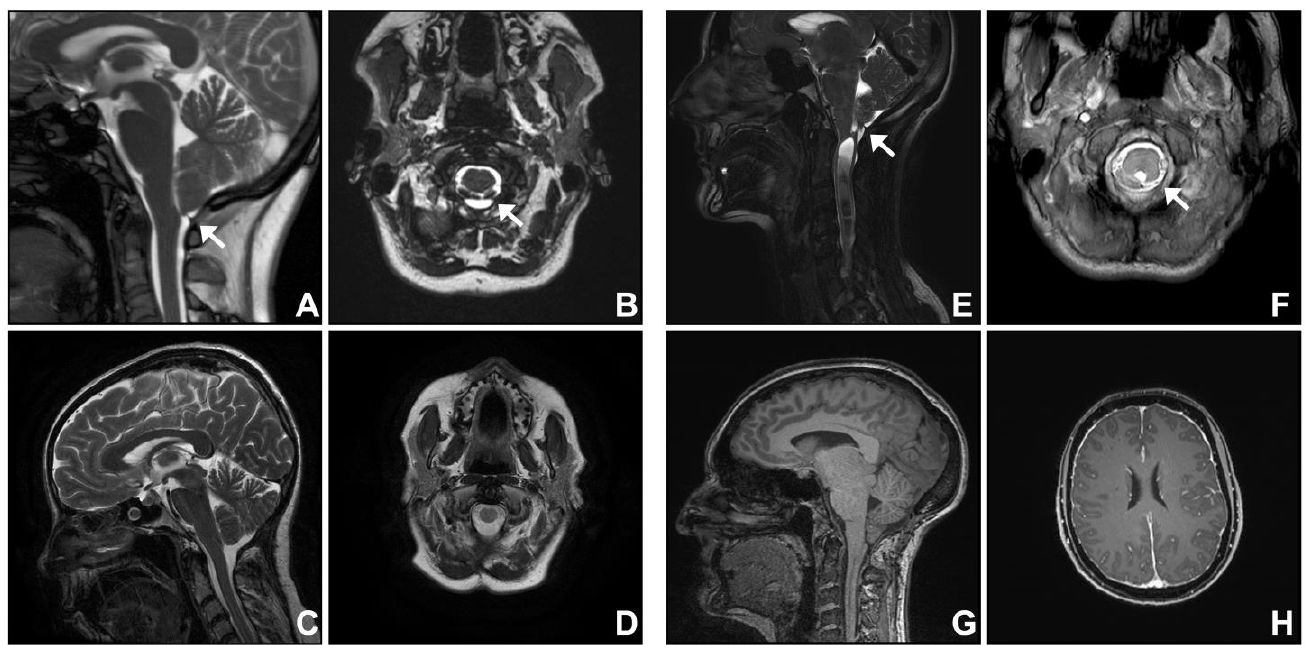
Figure 2. Chiari mimic: dural band. A 41-year-old woman ( A – D ) presented with a 4-year history of occipital headache and neck and bilateral upper limb pain. Cardiac gated steady-state free precession (SSFP or bFFE) imaging as well as thin-slice, heavily T2-weighted images showed cerebellar tonsillar descent, a thick dural band compressing the cerebellar tonsils (( A , B ); white arrows), and a resultant reduction of cisterna magna ( A , B ). Decompression surgery and division of the dural band restored the cisterna magna to a normal size ( C , D ). A 49-year-old woman ( E–H ) presented with a 9-year history of hearing changes and sensory disturbance in the left upper limb and trunk. An MRI showed cerebellar tonsillar descent 7 mm below the foramen magnum up to the C1 arch with a communicating cervico-thoracic syrinx ( E ). In addition, compression of the tonsils at the cervico-medullary junction was evident from a distinct septation posteroinferior to the cerebellar tonsils (( E,F ); white arrows) on cardiac-gated cine bFFE sequence ( E,F ). Following posterior fossa decompression, there was persistent cerebellar tonsillar descent, and imaging features were indicative of intracranial hypotension: prominent dural venous sinuses, diffuse pachymeningeal enhancement, pituitary gland enlargement, flattening of the pons, and dorsal beaking of the tectum ( G,H